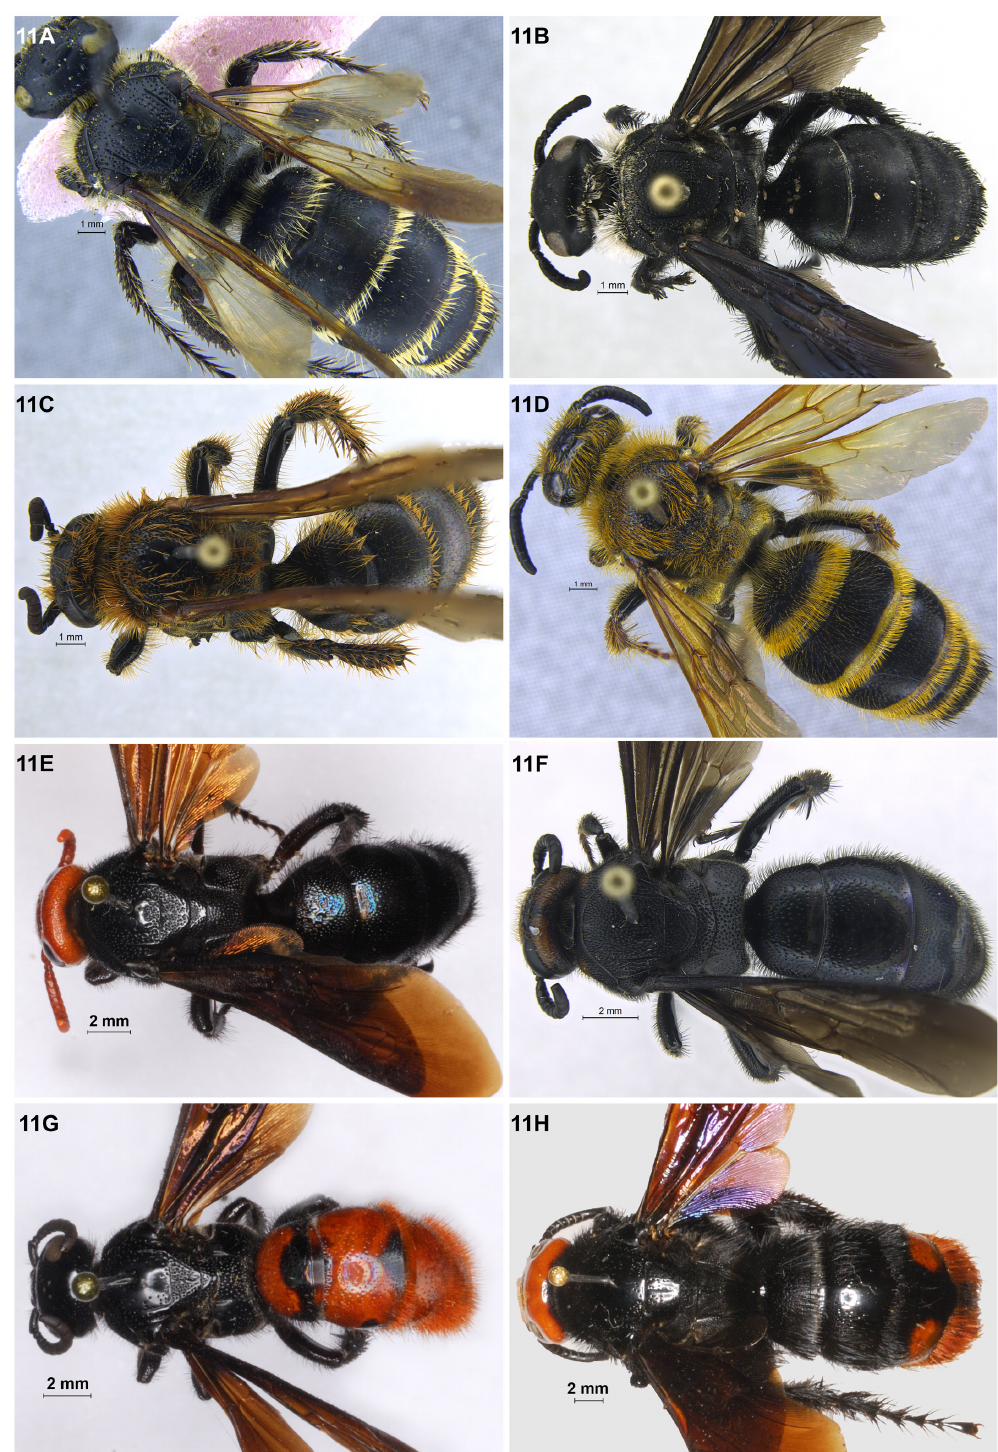
Fig. 11. Females, dorsal habitus. A . Campsomeriella annulata annulata (Fabricius, 1793). B . Camps. collaris (Fabricius, 1775) . C . Megacampsomeris formosensis chinensis Betrem, 1941. D . Phalerimeris phalerata phalerata (de Saussure, 1858). E . Austroscolia ruficeps ruficeps (Smith, 1855). F . Carinoscolia junnanensis (Betrem, 1928). G . Liacos erythrosoma (Burmeister, 1854). H . Megascolia azurea (Christ,